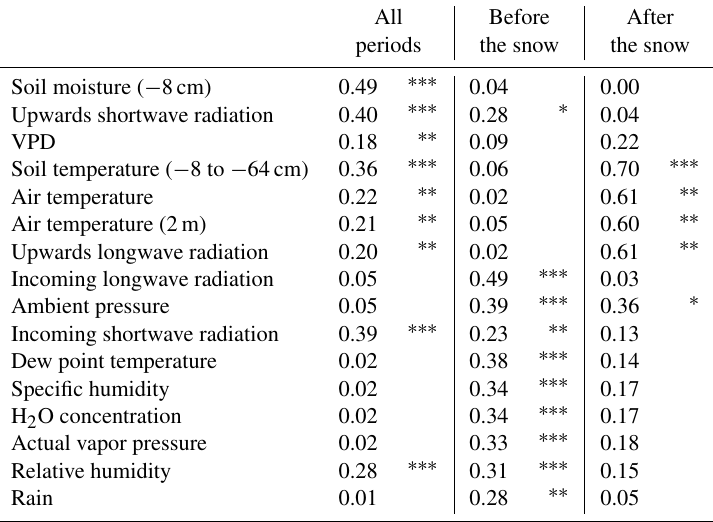
Table 9. R 2 values for correlations between the 18 O composition of nighttime CO 2 exchange R 18 eco O and different meteorological variables. Significance thresholds are given by ∗∗∗ for p < 10 − 4 , ∗∗ for p < 10 − 3 and ∗ for p < 10 − 2 . For some parameters the height above the ground (with negative values indicating the depth below the ground) is given in brackets; the parameters without such indication are measured 42m above the ground. All Before After